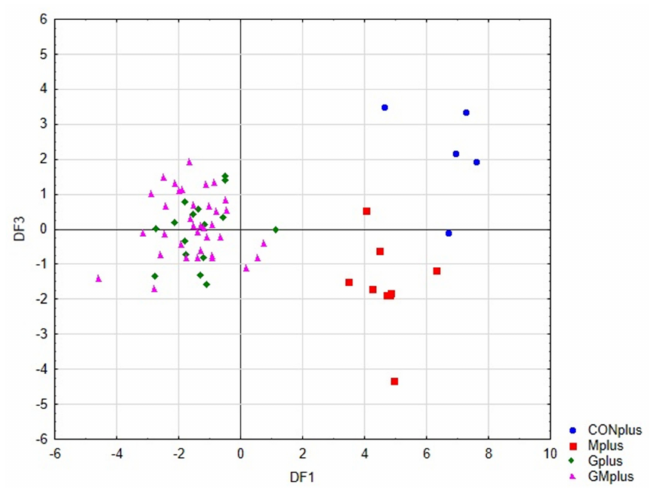
Figure 4. Scatterplot of canonical values for functions DF1 and DF2.